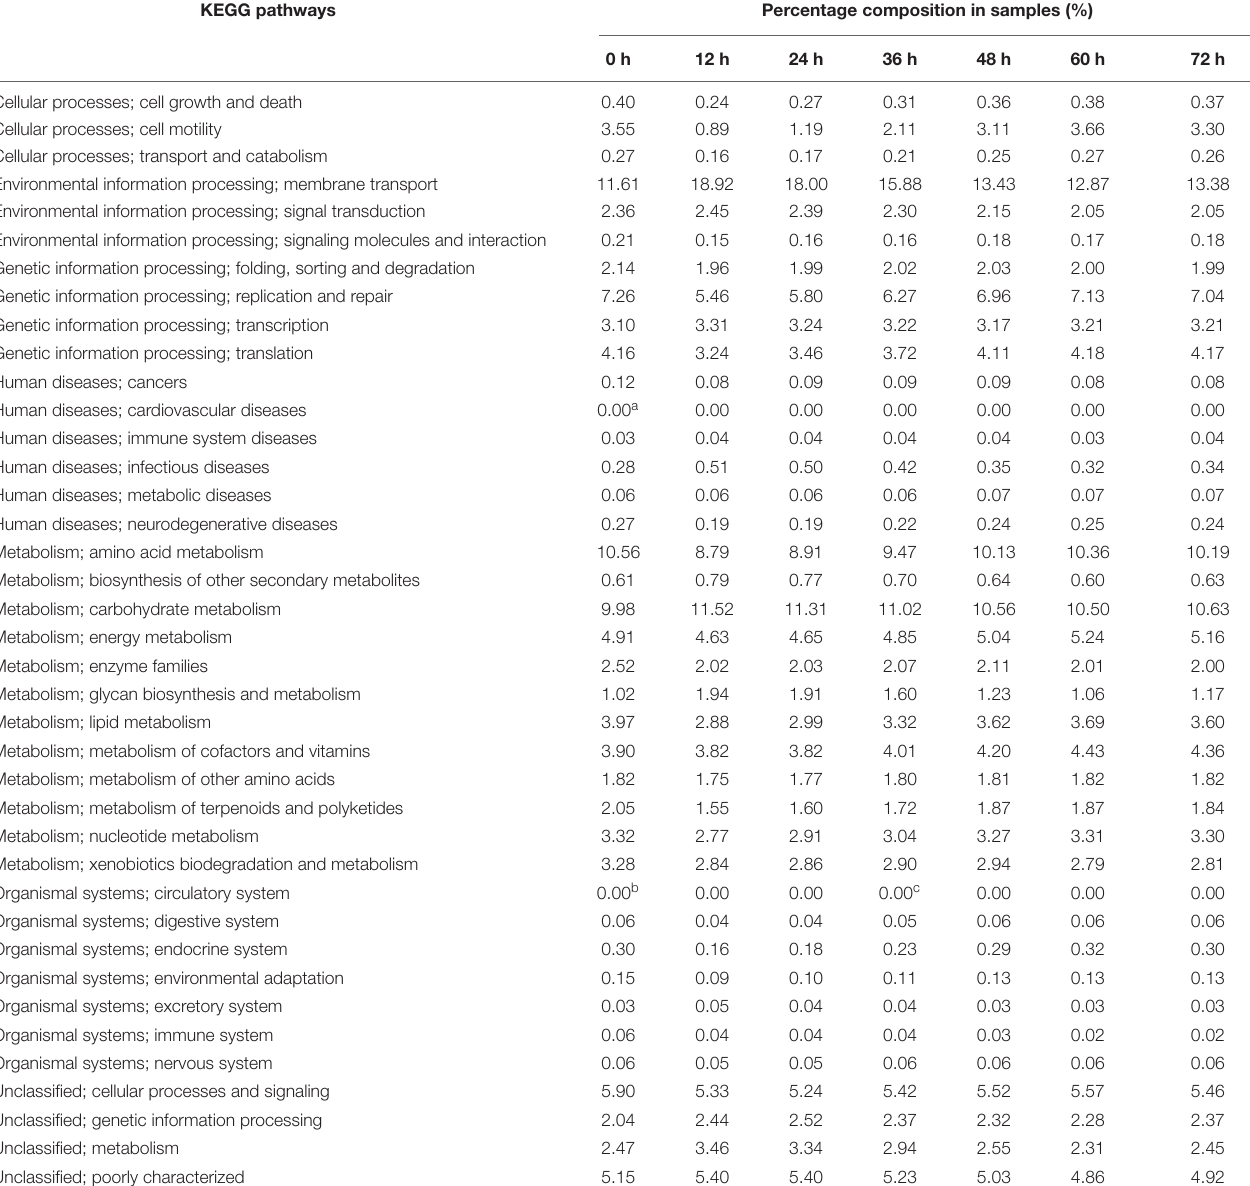
TABLE 7 | The KEGG functional annotation of bacterial 16S rDNA in the non-post fermented Shuidouchi. KEGG